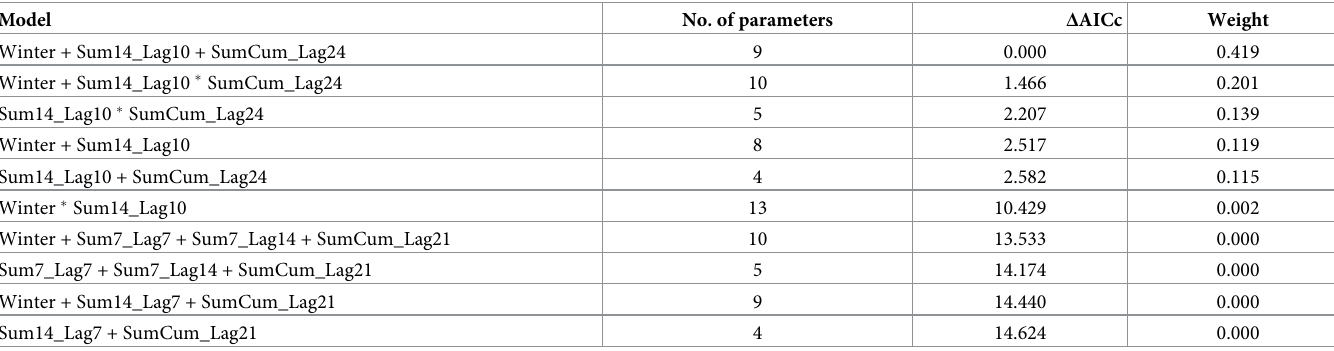
Reports of cold-related carcasses were modeled using a negative binomial generalized linear model, and models were ranked using the AICc value. Temperature variables used in the models are described in Fig 2. Full model results are presented in S6